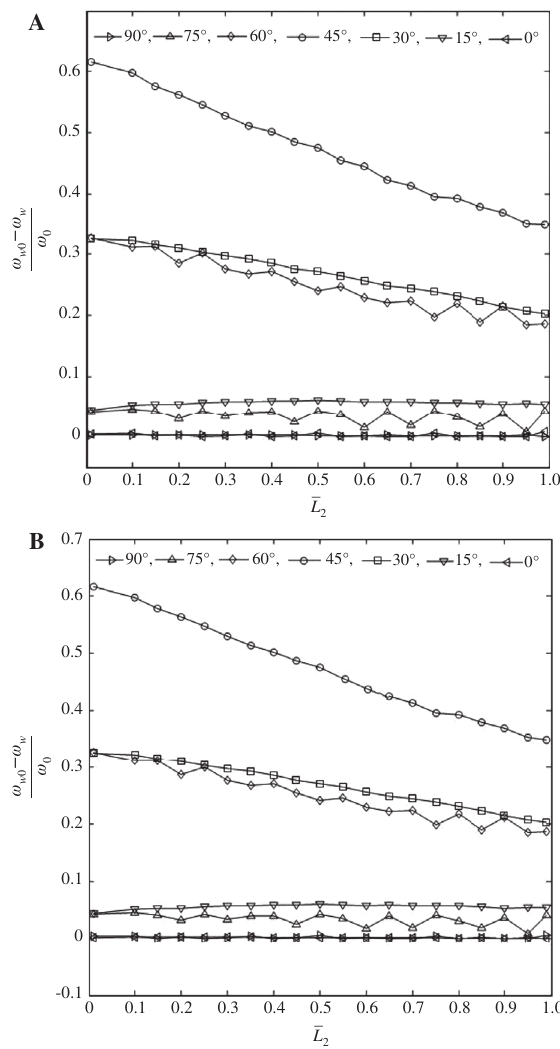
Figure 7 The influence of Poisson’s effect on the fundamental natural frequencies of the delaminated LCB ( L/h = 15). (A) Free mode. s (B) Constrained